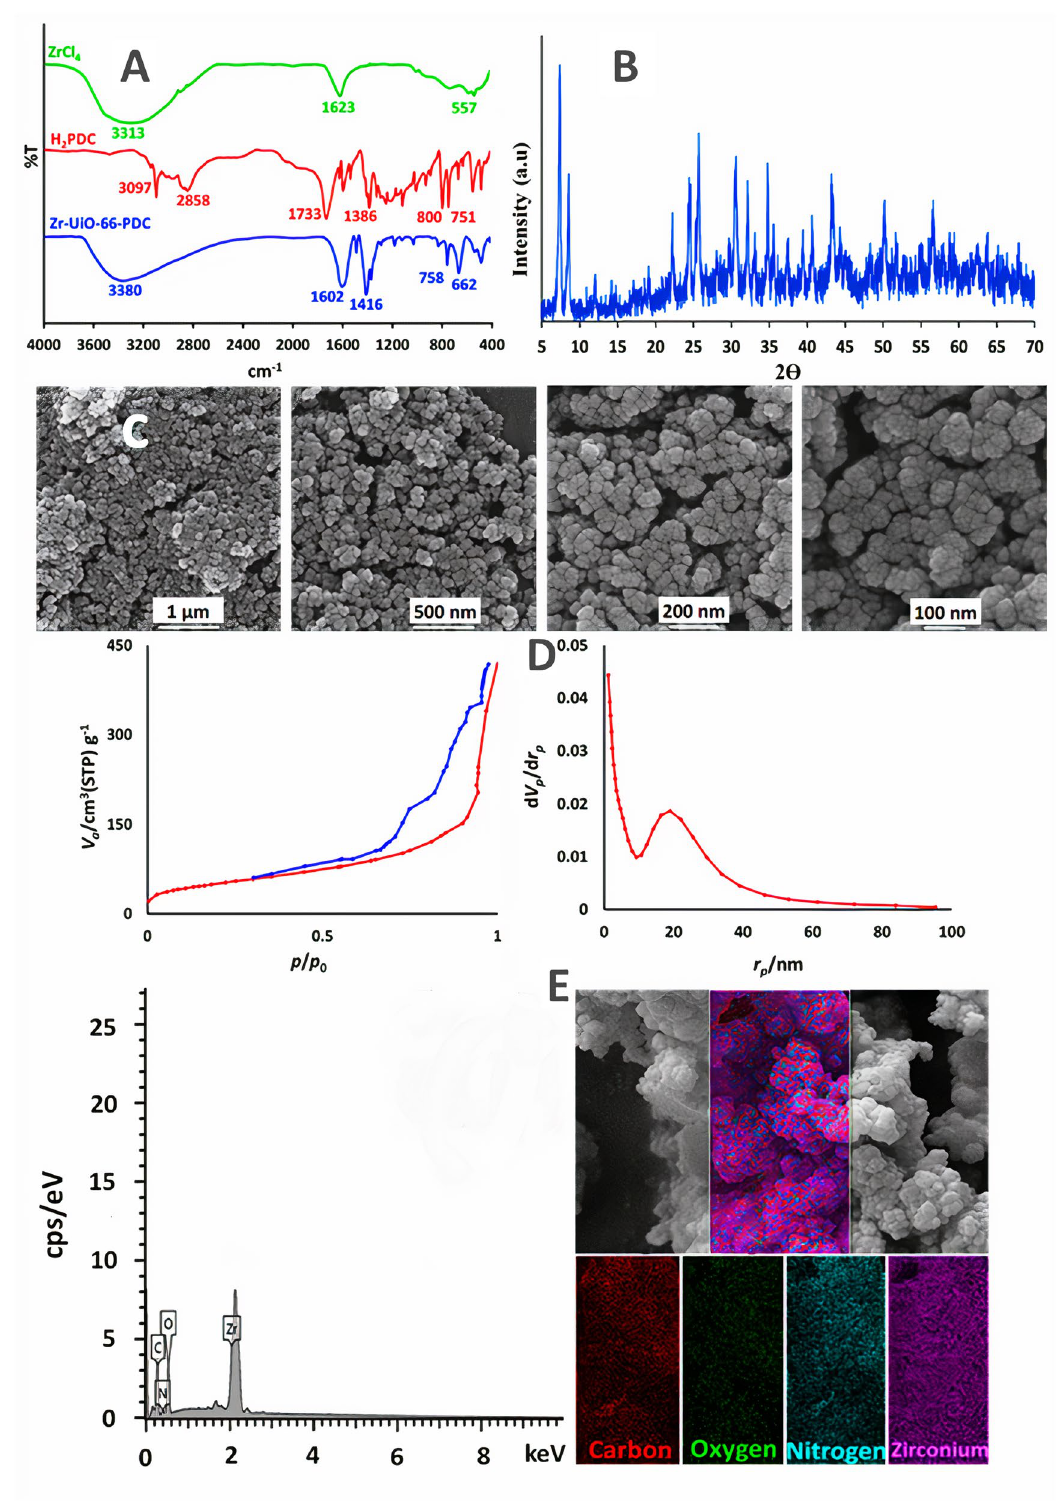
Figure 8. ( A ) FT-IR spectra of pyridine-2,5-dicarboxylic acid (H 2 PDC), ZrCl 4 and Zr-UiO-66-PDC. ( B ) Powder X-ray diffraction (PXRD) pattern of electrosynthesized Zr-UiO-66-PDC. ( C ) Large- and close-view FE-SEM images of Zr-UiO-66-PDC by constant current electrolysis at I = 30 mA cm −2 and t = 1800s. ( D ) N 2 adsorption/desorption isotherm. BET and BJH of Zr-UiO-66-PDC by the constant current electrolysis at I = 30 mA cm −2 and t = 1800s. ( E ) Energy-dispersive X-ray spectroscopy (EDX) and elemental mapping analysis of electrosynthesized Zr-UiO-66-PDC. The structures of the compounds were drawn using ChemOffice 12.0